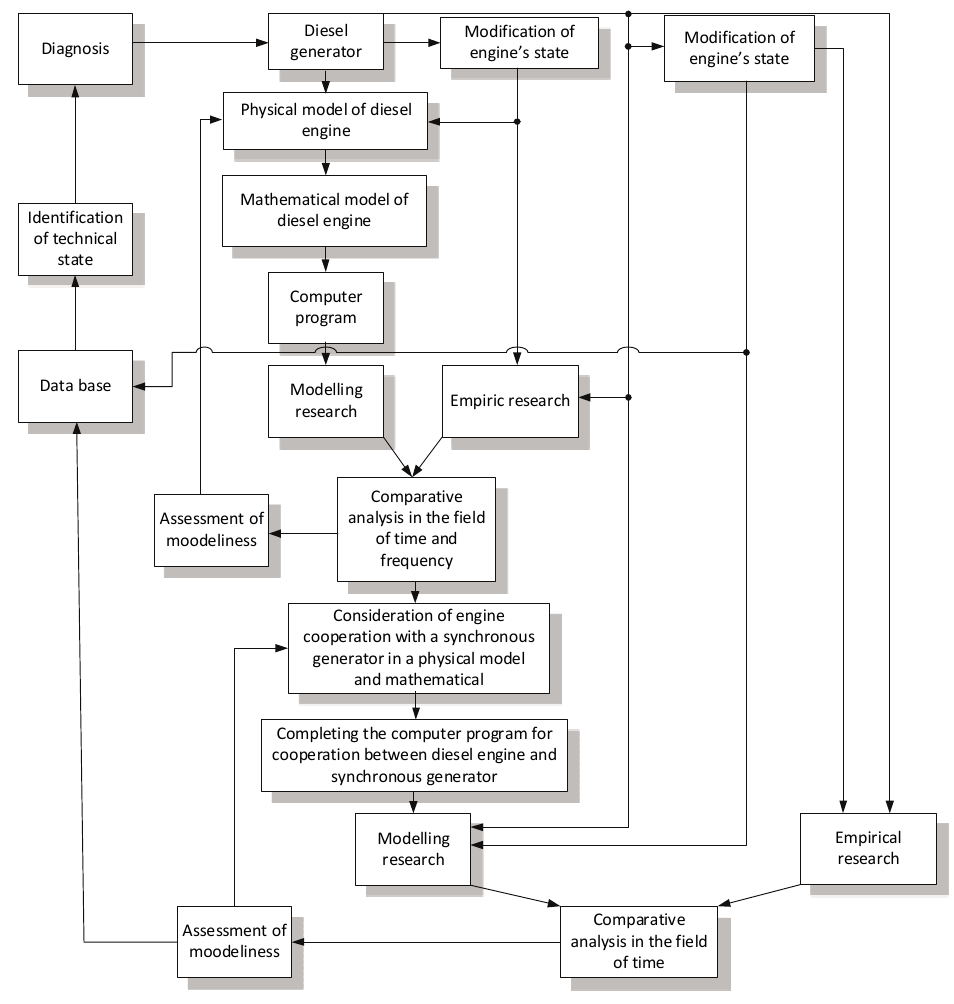
Fig. 1. RDE tests requirements in Europe [4,